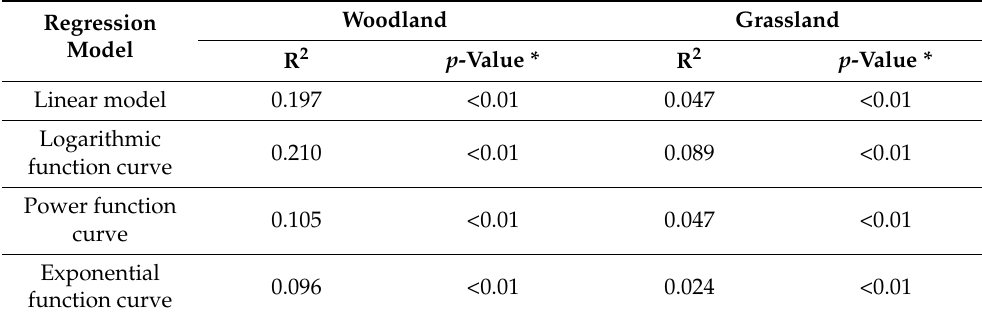
Table 4. Comparison of the goodness of fit of regression